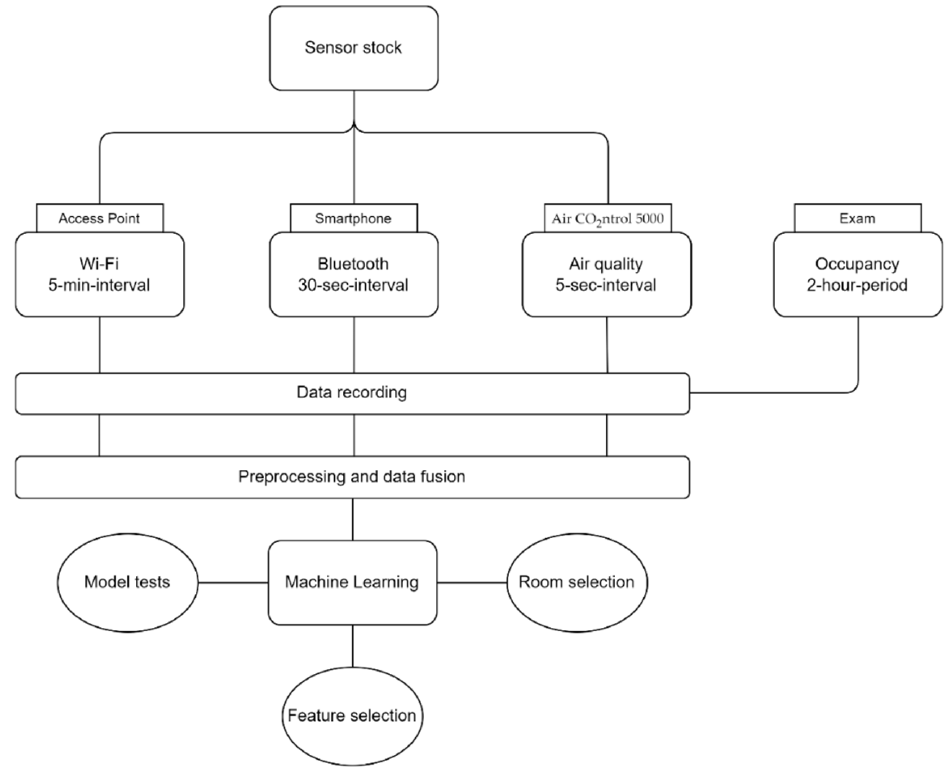
Figure 1. Methodology flow chart.